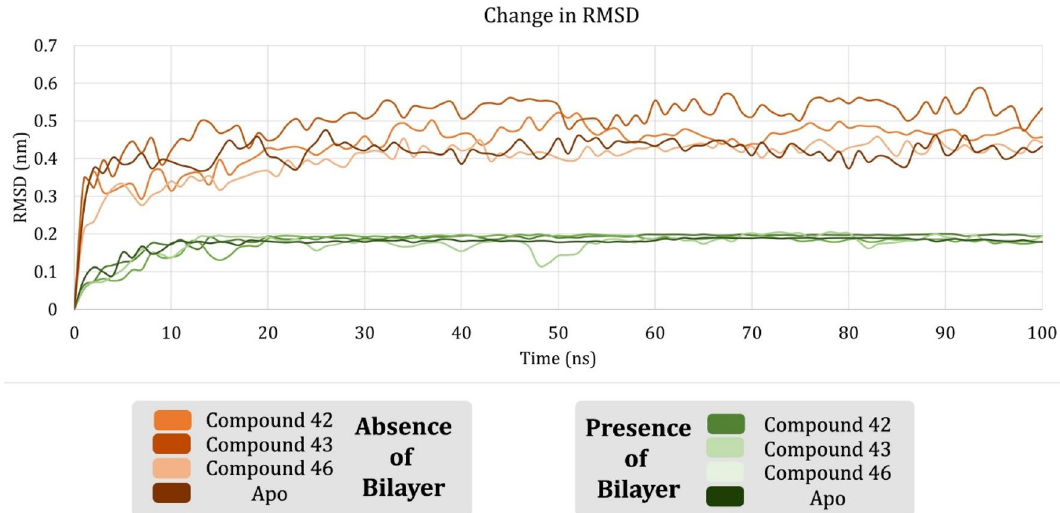
Figure 2. Comparing the time evolution plots of the RMSD of backbone Cα atoms in the presence and absence of a lipid bilayer. The systems showed better equilibration in the presence than in the absence of lipids.